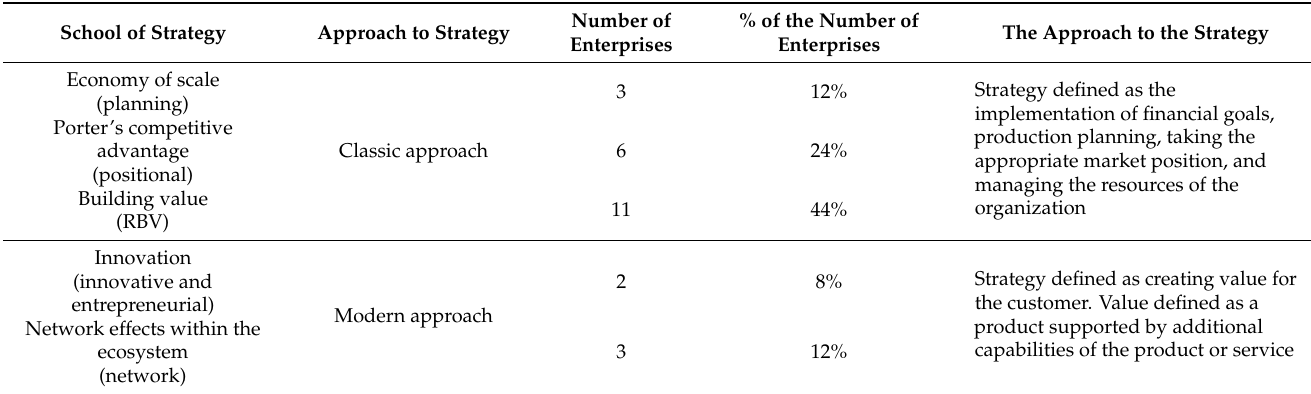
Table 5. Classification of approaches to the strategy.